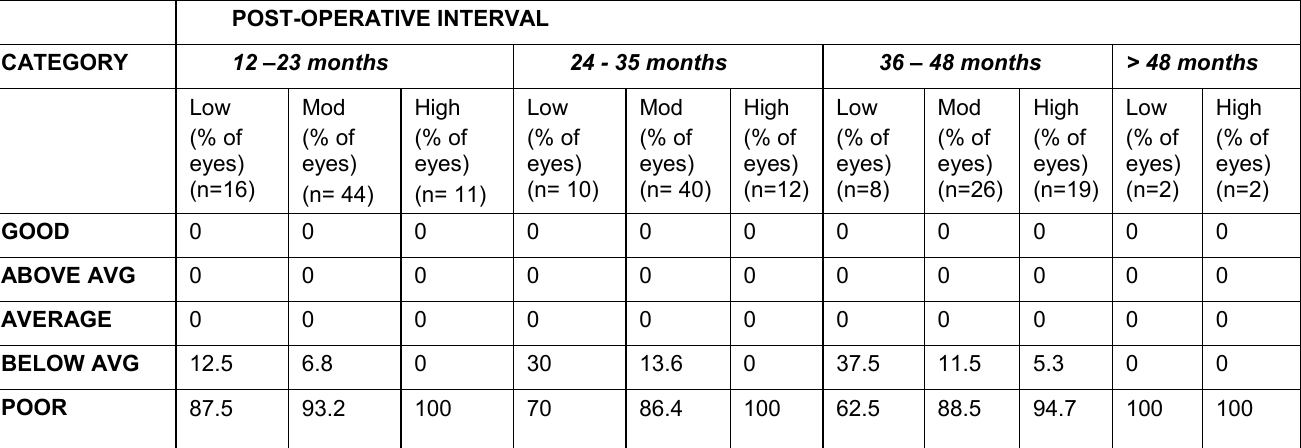
Table 2 . Categorization of night vision thresholds for the different degrees of pre-operative refractive errors in the different post-operative